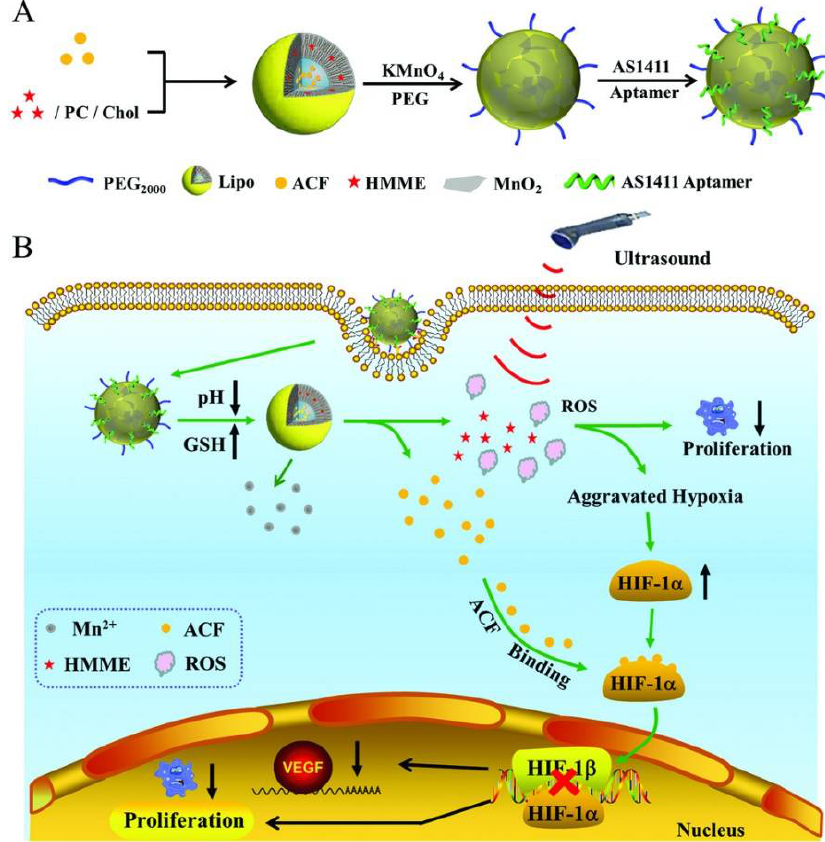
Figure 5. ( A ) Synthesis of Lipo/HMME/ACF@MnO2-AS1411. ( B ) Proposed mechanism of Lipo/HMME/ACF@MnO2-AS1411 for amplification of sono-dynamic therapy. Copyright (2018)